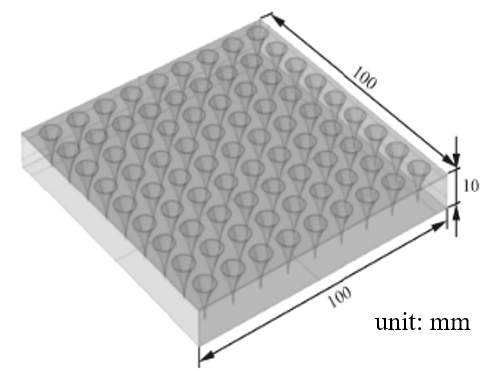
Figure 19. The diagram of the ideally designed acoustic black hole superstructure [63].